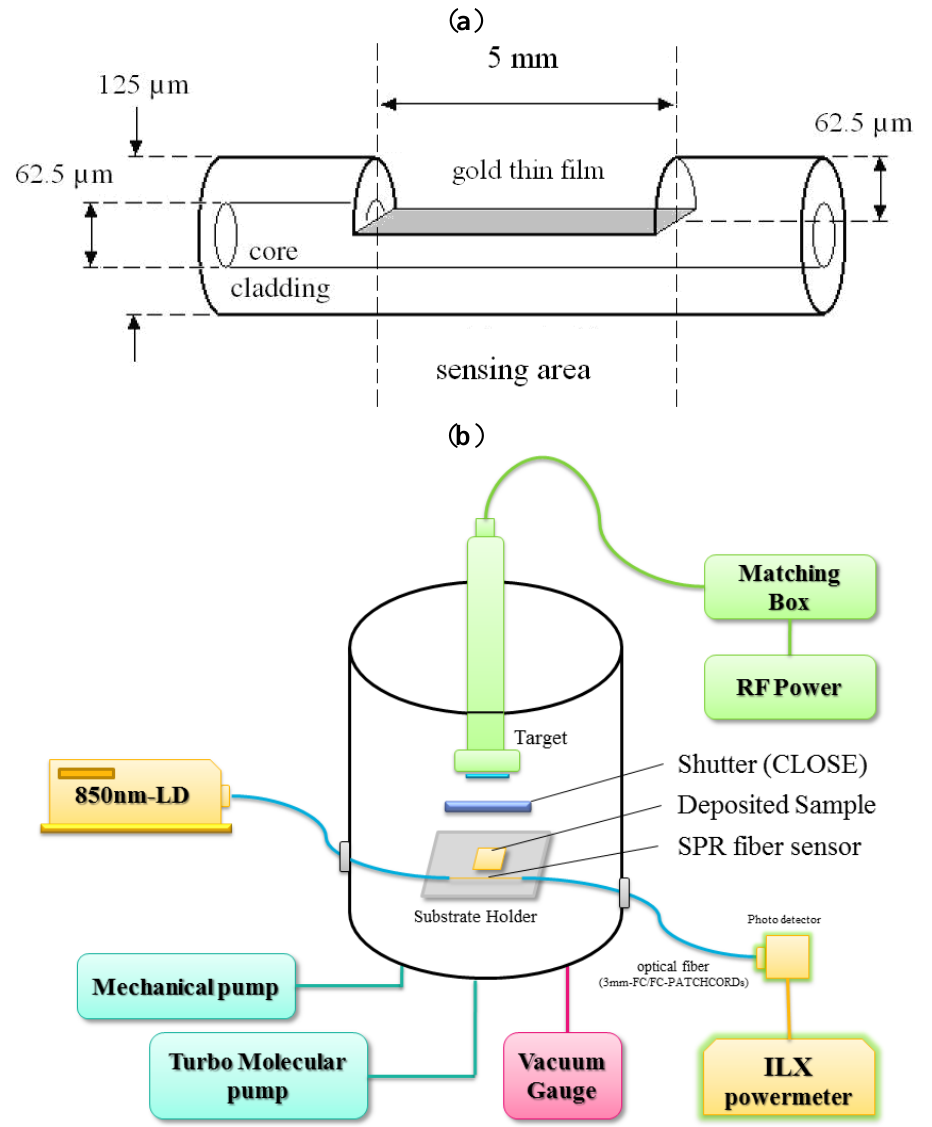
structure. (b) Schematic diagram of the PVD sputtering system and SPR optical fiber sensing